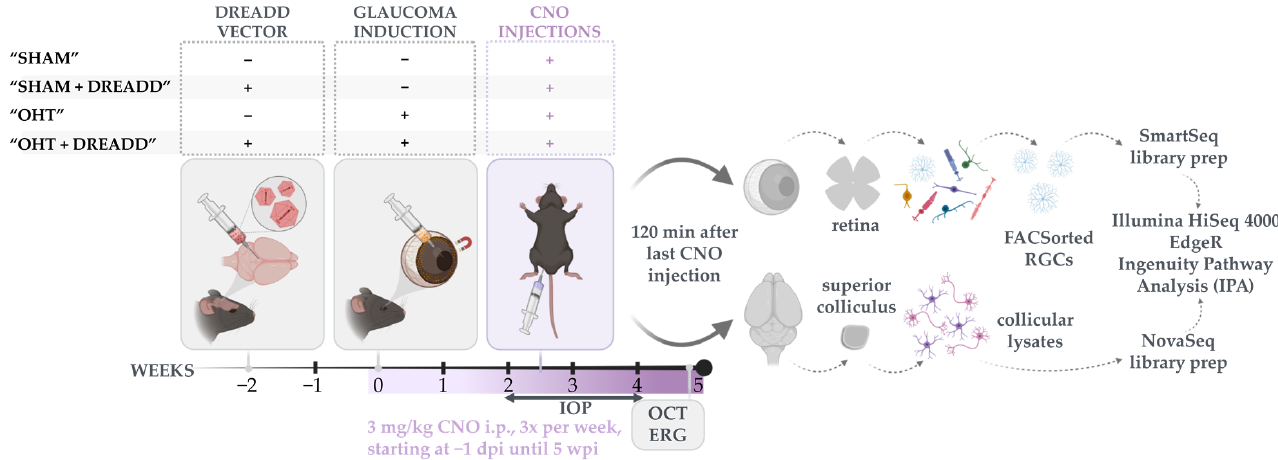
Figure 2. Schematic diagram of the experimental design. Two weeks after DREADD or null vector injections in the superior colliculus, ocular hypertension (OHT) was induced via intracameral injection of magnetic microbeads versus saline for SHAM controls. All mice received clozapine-N-oxide (CNO) injections (i.p., 3 mg/kg, 3 days/week), starting 1 day before glaucoma induction until five weeks later. As depicted, four experimental groups were included in this study: “SHAM”, “OHT”, “SHAM + DREADD” and “OHT + DREADD”. Assessed read-outs were longitudinal intraocular pressure measurements (IOP) and several endpoint (five weeks post injury) measurements: optical coherence tomography (OCT), electroretinography (ERG), and bulk RNA sequencing. For the bulk RNA sequencing study, both collicular lysates, as well as isolated RGCs via fluorescence-activated cell sorting (FACS) were collected. Downstream analysis was performed with EdgeR and Ingenuity Pathway Analysis